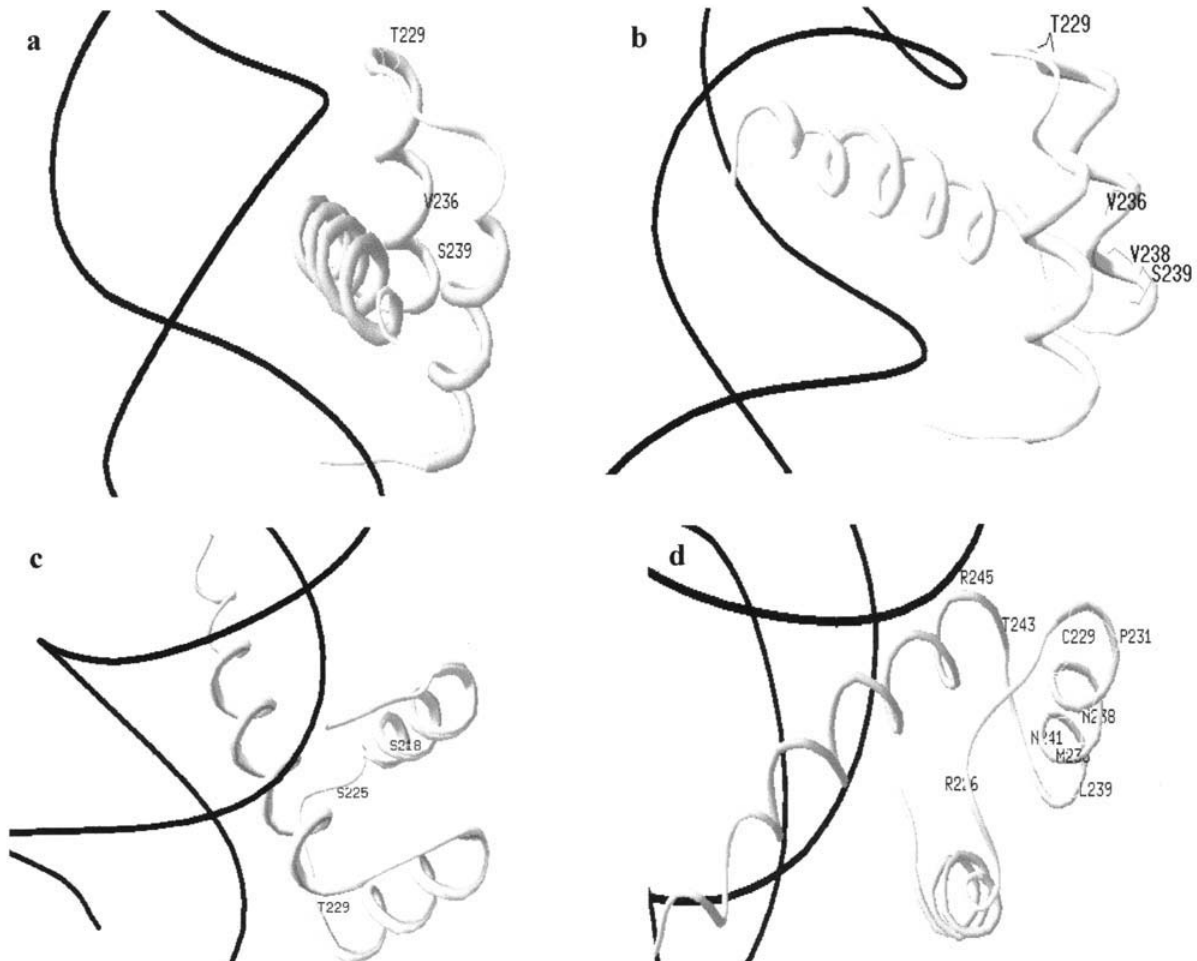
Figure 4 - Swiss-PdbViewer (ribbon diagram) representation of the homology-modeled homeodomain-DNA (HD-DNA) complex for (a) Austrolebias cheradophilus , (b) Austrolebias gymnoventris , (c) Austrolebias luteoflammulatus and (d) Austrolebias bellottii . Selected residues within the homeodomain that were identified in our alignments are indicated in each model. In all four species none of the altered residues was predicted to interact directly with the